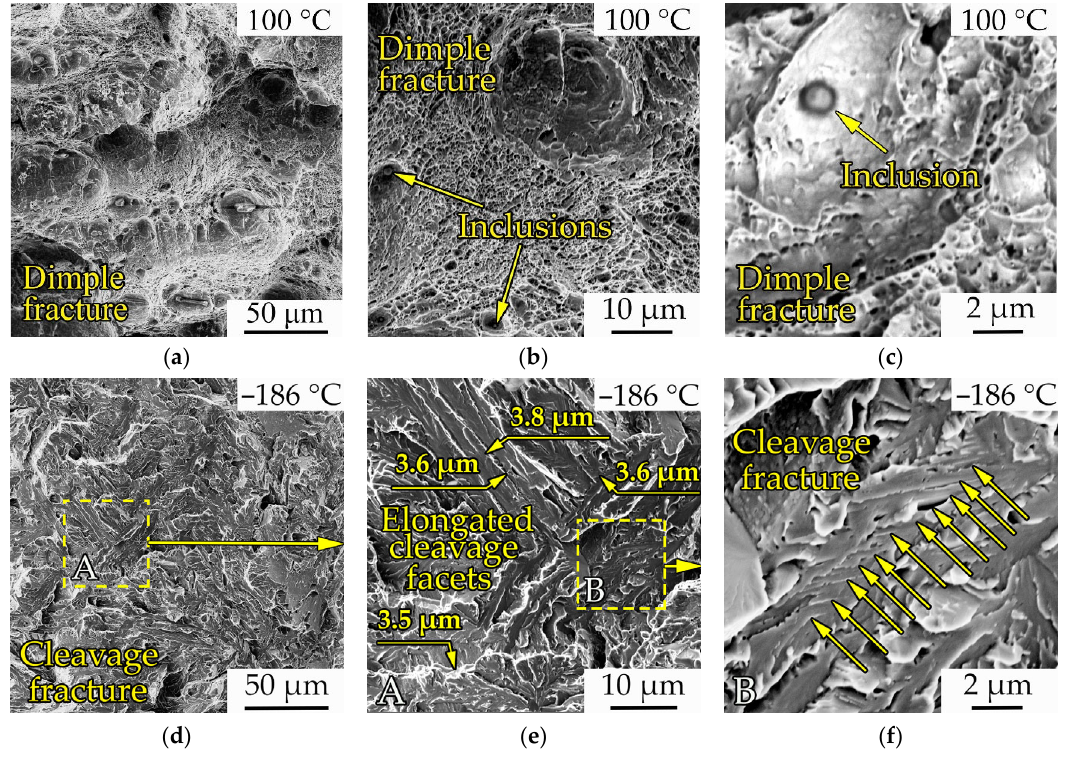
Figure 11. Fractographic images of the central part of steel EK ‐ 181 impact samples after THT, fractured at 100 °C ( a – c ) and − 186 °C ( d – f ). Sections A and B highlighted by dotted rectangles are shown in Figures ( e , f ) .